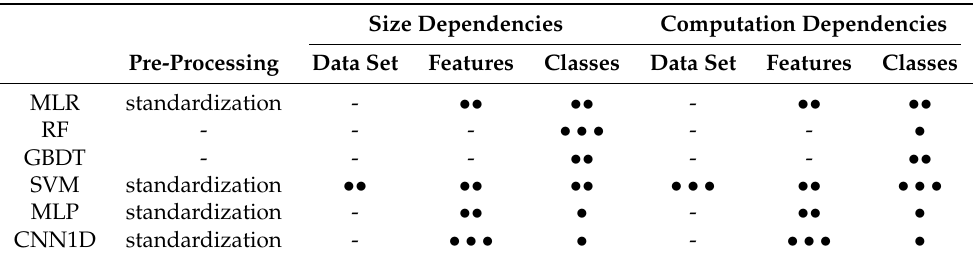
Table 1. Summary of the size and computational requirements of the considered